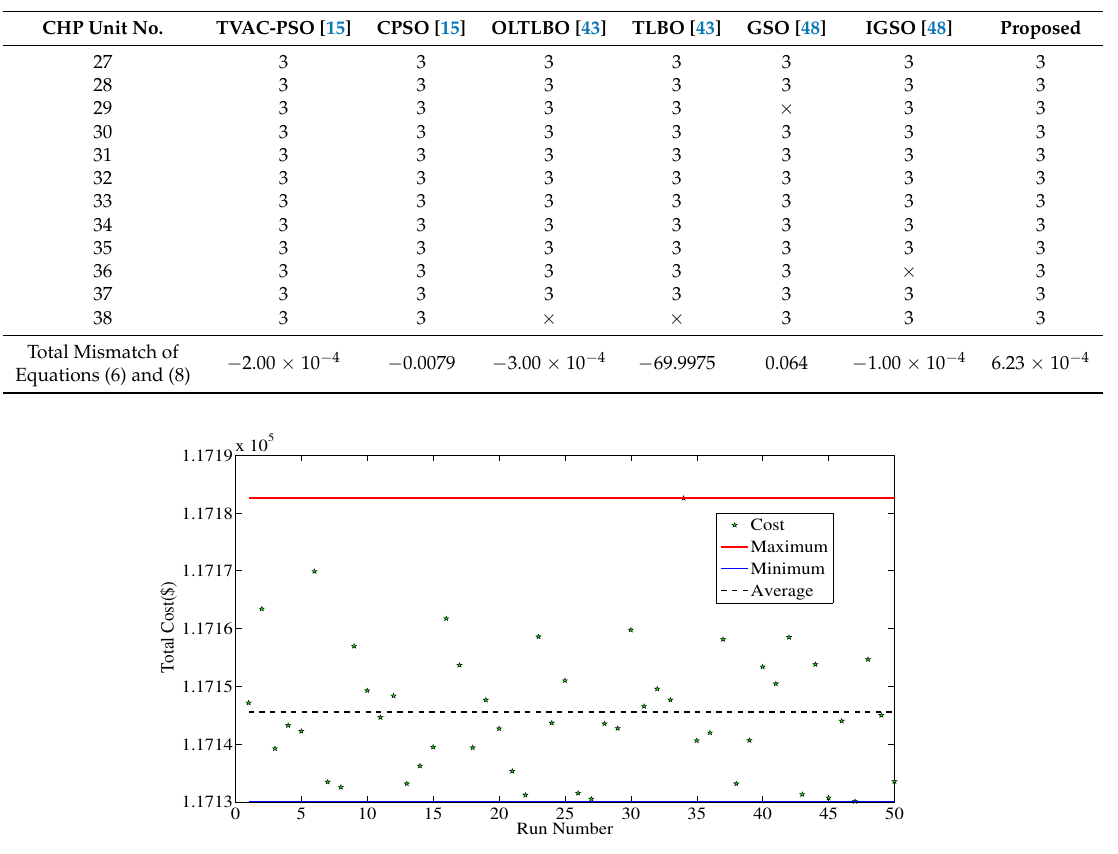
Figure 8. Distribution of total costs for 50 independent runs for 48-unit test system.